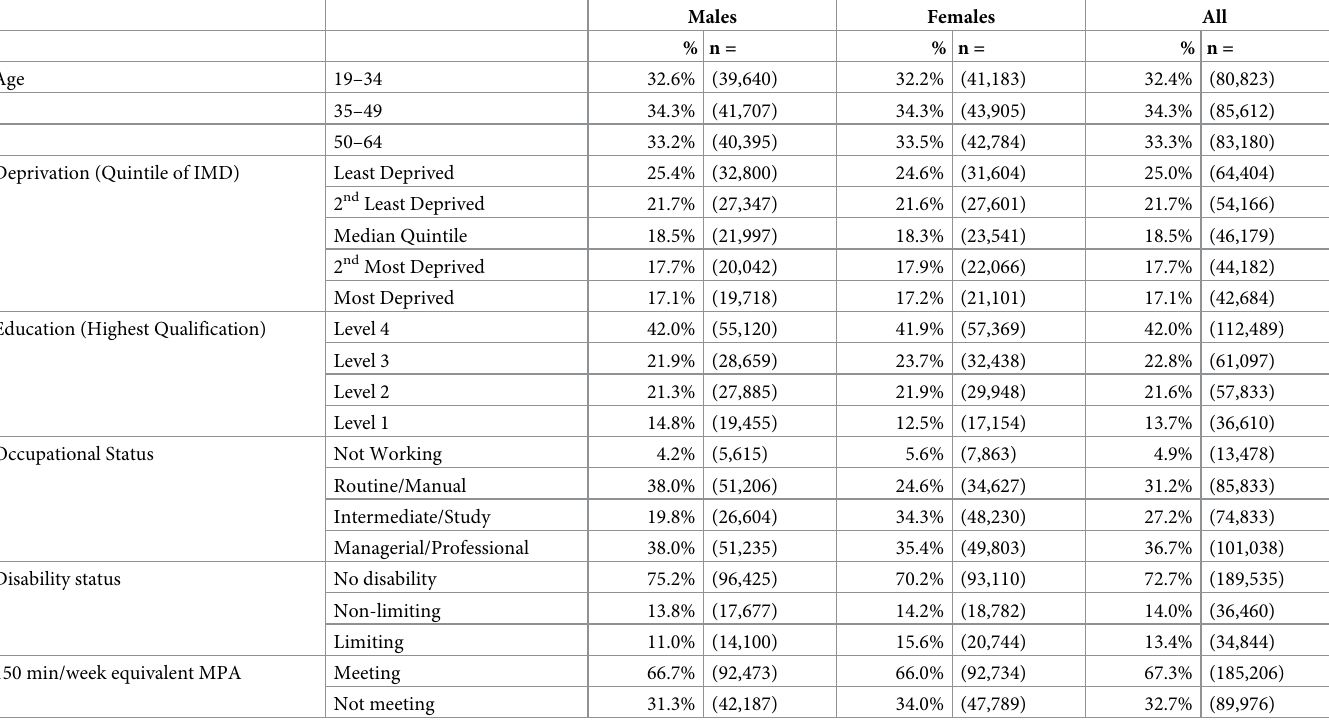
Table 1. Sociodemographic characteristics of n = 275 182 English adults responding to Active Lives survey Waves 2 and